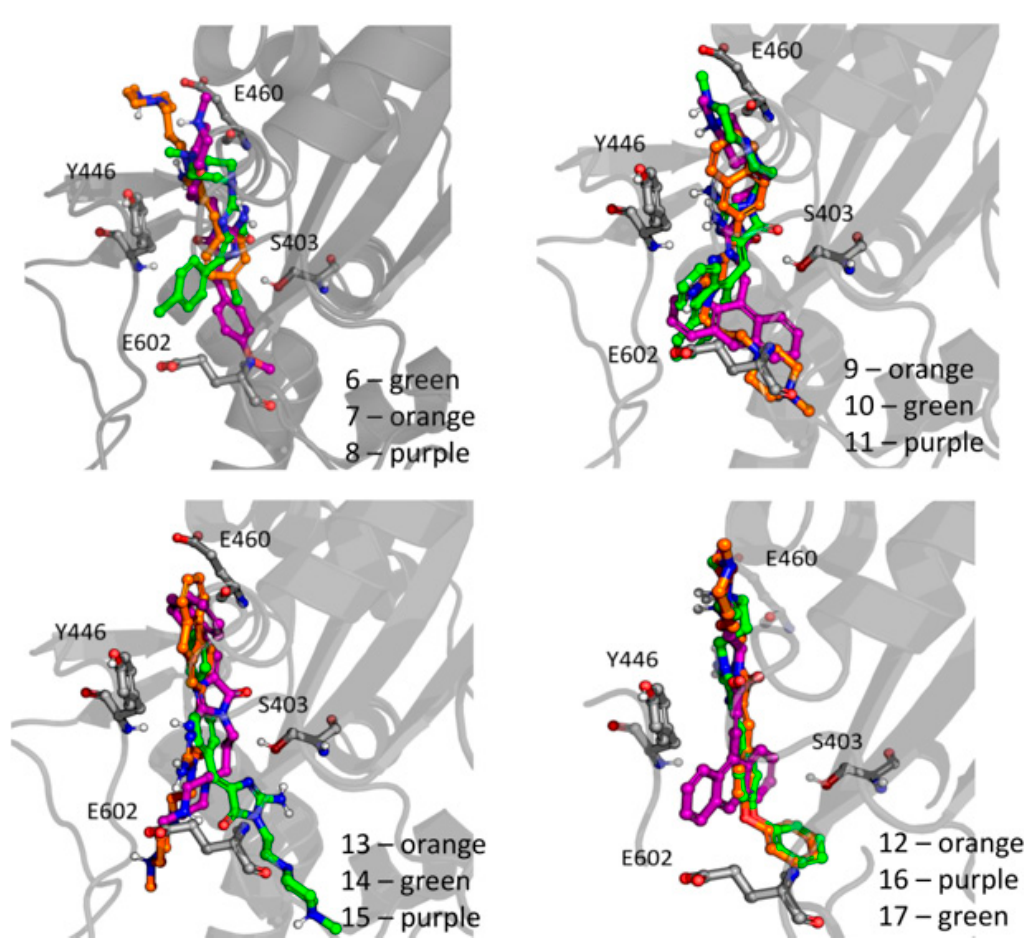
Figure 6. Docking poses of the studied compounds in the active site of PBP2a (grid centered at S403)